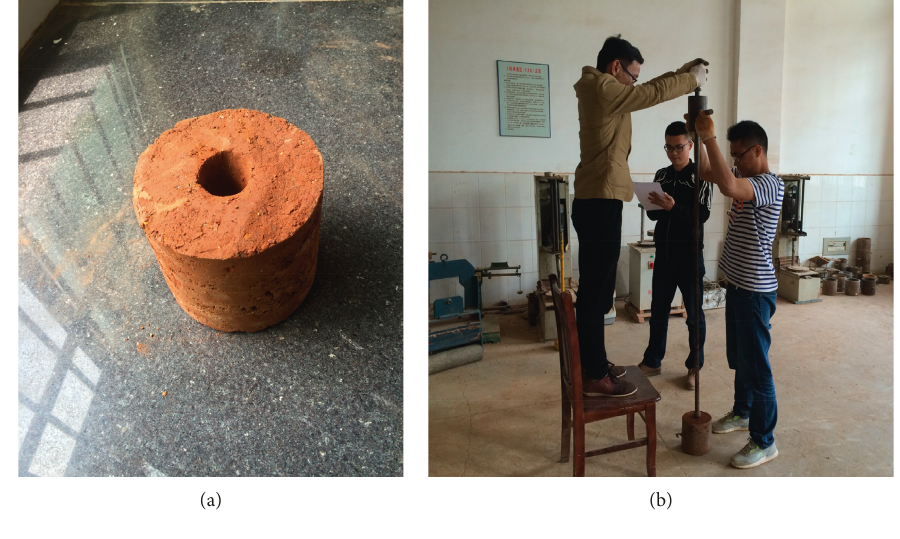
Figure 2: LDP-based lab test.